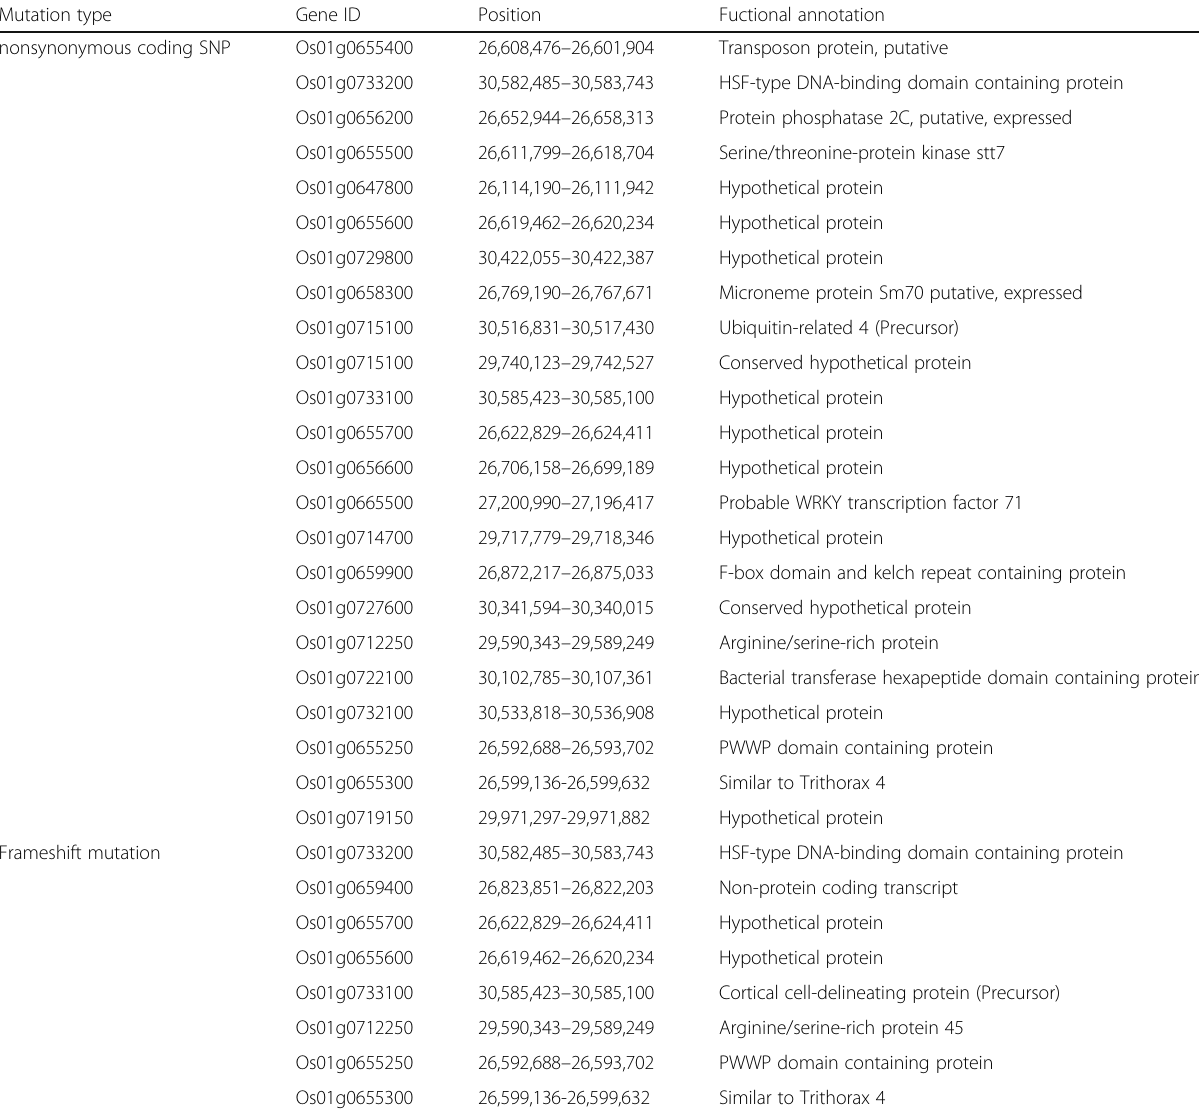
Table 5 The candidate genes for salt tolerance based on the index and ED of SNP and InDel Mutation type Gene ID Position Fuctional annotation nonsynonymous coding